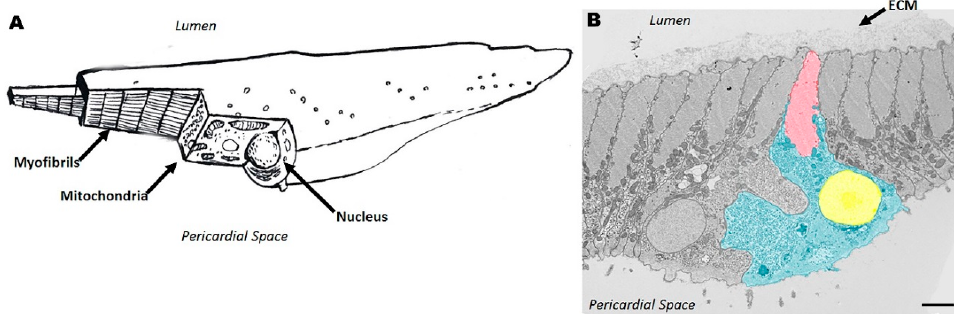
Figure 4. Cardiac Myocyte in the Ciona myocardium. ( A ) Schematic of a cardiac myocyte with sectioned areas to show intracellular organization; and ( B ) false-colored TEM of Ciona myocardium with highlighted cardiac myocyte ( red = myofibrils; yellow = nucleus; blue = sarcoplasm). Unknown extracellular matrix is continuous on sarcolemma of cardiac myocytes facing lumen of heart. The nucleus is oriented towards the pericardial space. Scale bar = 2 microns. Cardiac myocytes in Ciona are polarized cells that have nuclei oriented toward the apical pole facing the pericardium and myofilaments on the basal side facing the lumen of the heart (Figure 4). Myofilaments are striated and widely extend away from the central portion of the cell containing the nucleus. Binucleation occurs in ascidian cardiac myocytes, but the rate of occurrence has not been quantified. Ciona cardiac myocytes are in excess of 100 microns in length [20]. The myofilaments make